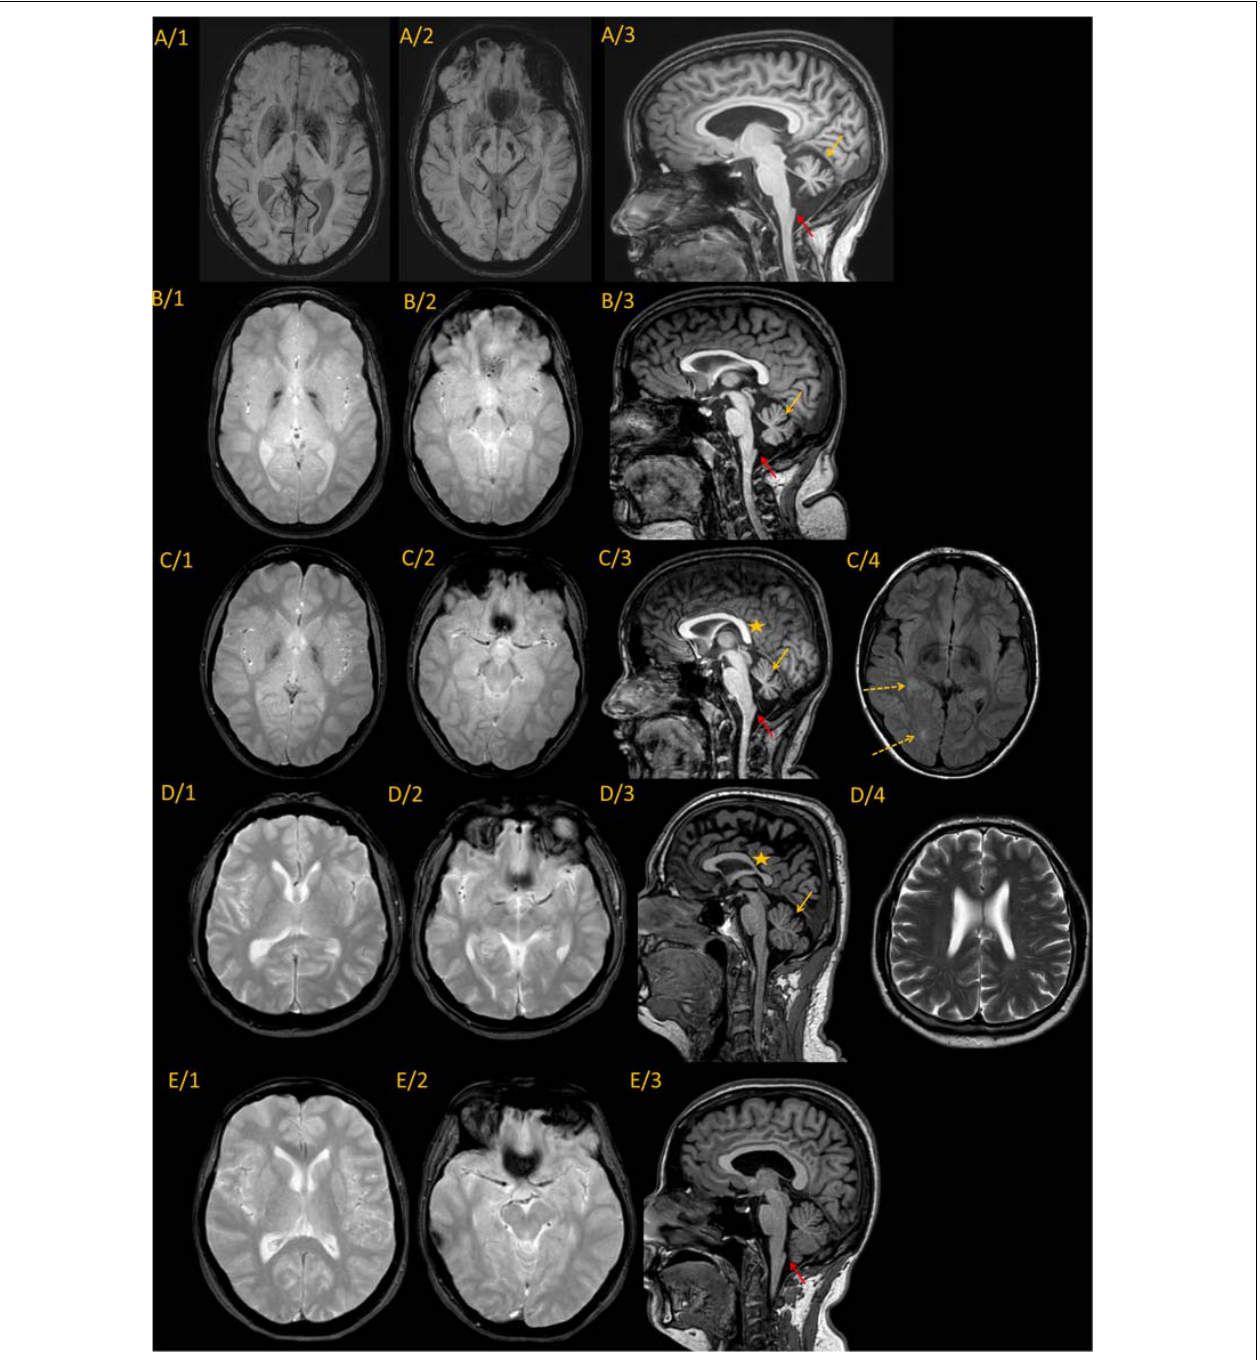
FIGURE 3 | Representative MRI imaging pictures of the family. Every line represents images from a single individual. (A) IV/2; (B) IV/3; (C) IV/4; (D) III/3; and (E) III/4 Column 1–2. Axial iron sensitive sequences (SWI in line A, and T2* in the remaining) through the basal ganglia and midbrain. Column 3: Sagittal midline T1 images. Findings are summarized in the associated table. Every patient diagnosed with PLAN (A–C) showed iron accumulation in the globi pallidi internus and substantiae nigrae, while the carrier parents did not show iron accumulation. Cerebellar atrophy was present in all the three affected children [ (A–C) , yellow arrows], and was also present at the father [ (D/3) , yellow arrow]. The characteristic vertical splenium corpus callosum was present at patient IV/4 [ (C/3) , yellow star], however, also at the father corpus callosum was atypical [markedly thin isthmus in an adult; (D/3) yellow star]. The apparent claval hypertrophy sign was present at all three affected children [ (A–C) , red arrow], and was identifiable at also the carrier mother [ (E/3) , red arrow]. Besides, patent IV/4 also had white matter lesions identifiable on T2 images [ (C/4) , dotted arrows]. At the father enlarged vascular spaces were detected (D/4) . In summary, it seems, that besides the characteristic PLAN-associated signs at the affected children, both parents showed mild abnormalities, which might be related to the PLA2G6 carrier state, without pathological iron accumulation.